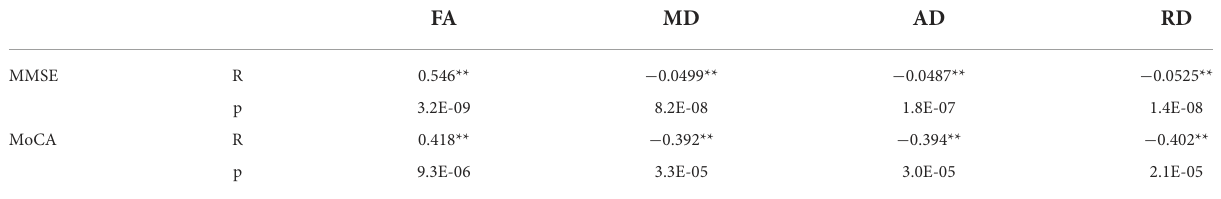
TABLE 7 Correlation analysis of diffusion parameters in damaged brain white matter areas with the MMSE and MoCA cognitive function scores.